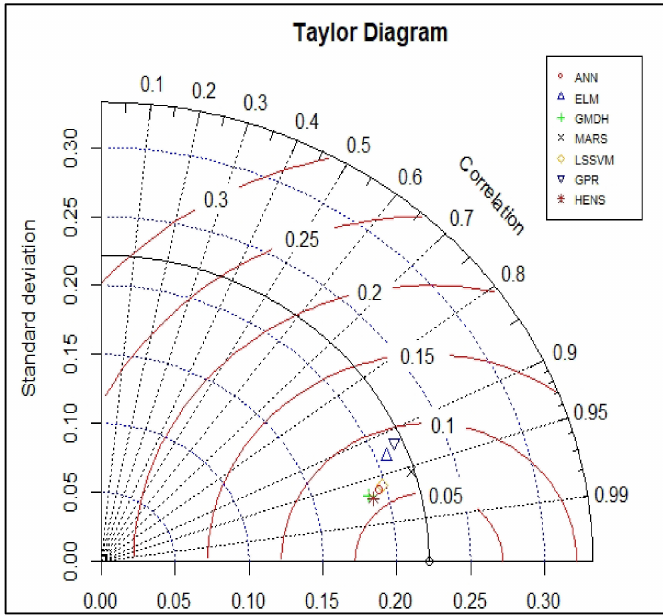
Figure 9. Taylor diagram of the testing